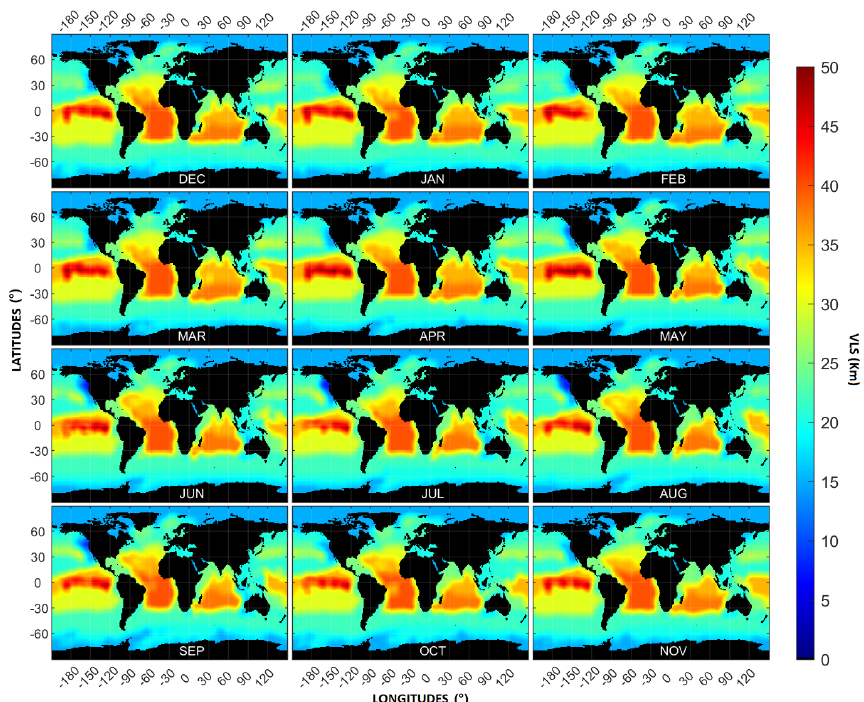
Figure 5. The DMS variability length scales (VLS) used for the weighted-average interpolation computation is shown. The VLS in 11 provinces was based on past observations, and the VLS in the other provinces was estimated by looking for biogeochemical